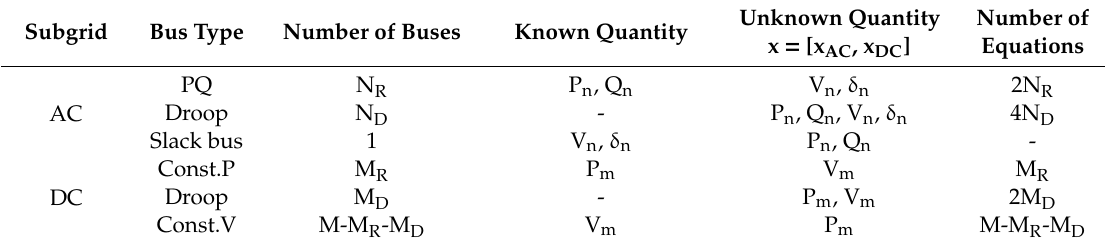
Table 4. The variables for the buses of IHMG.